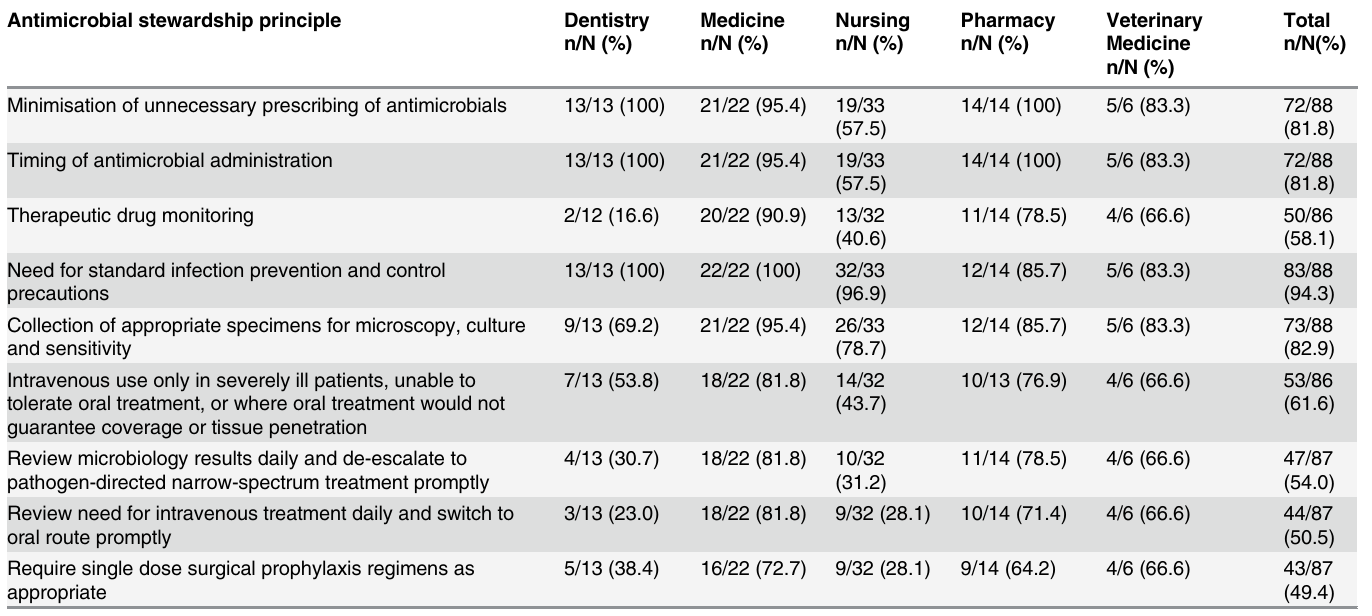
Table 2. Antimicrobial stewardship principles included in undergraduate education programmes, by